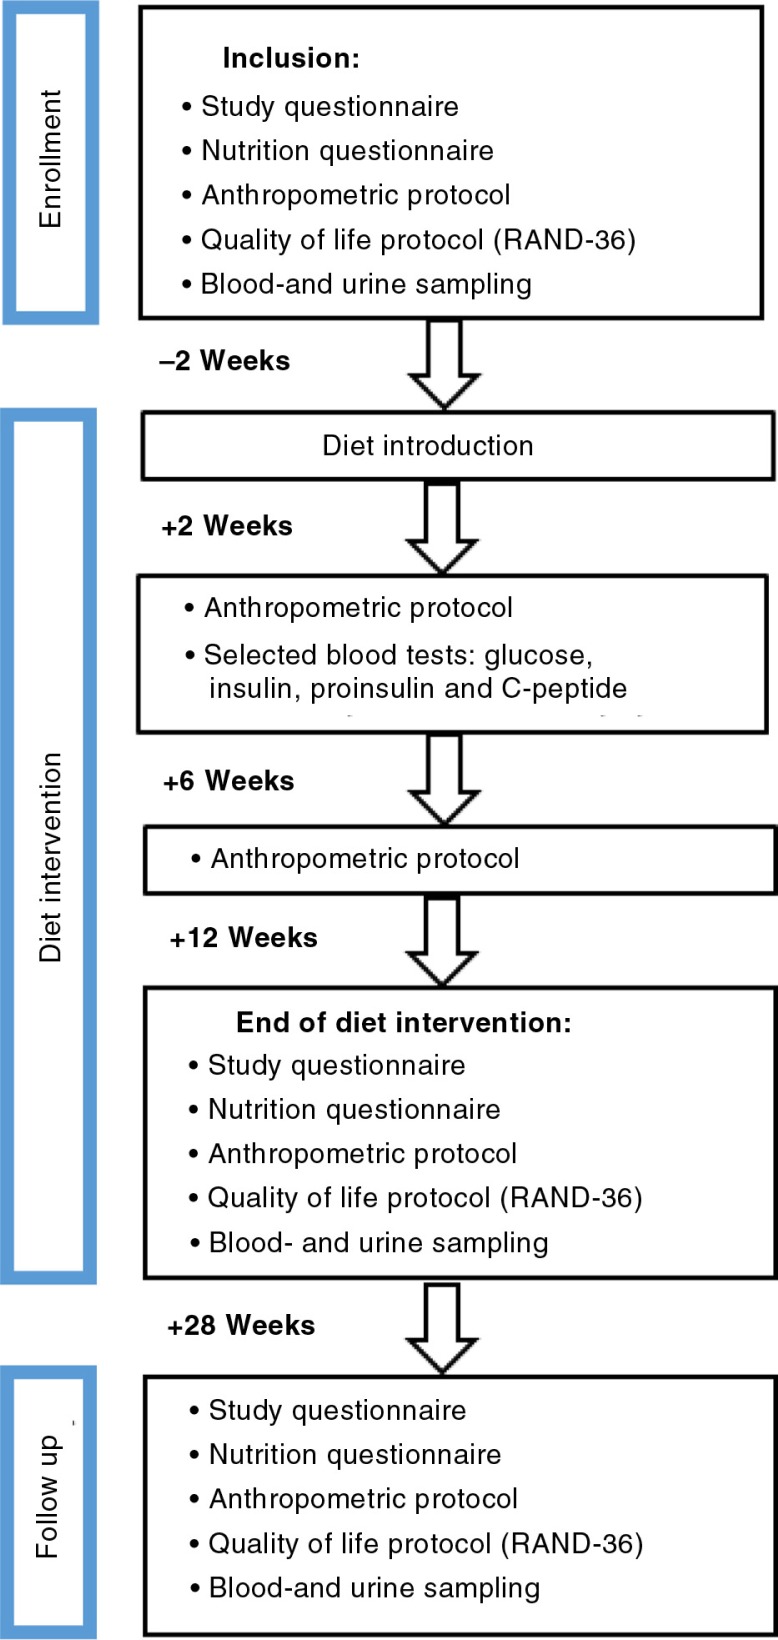
Flowchart of the design and phases of the Okinawan-based Nordic diet intervention study. Diet introduction followed a 2 week run-in period (2 weeks). The participants were followed up 16 weeks after the end of dietary intervention.